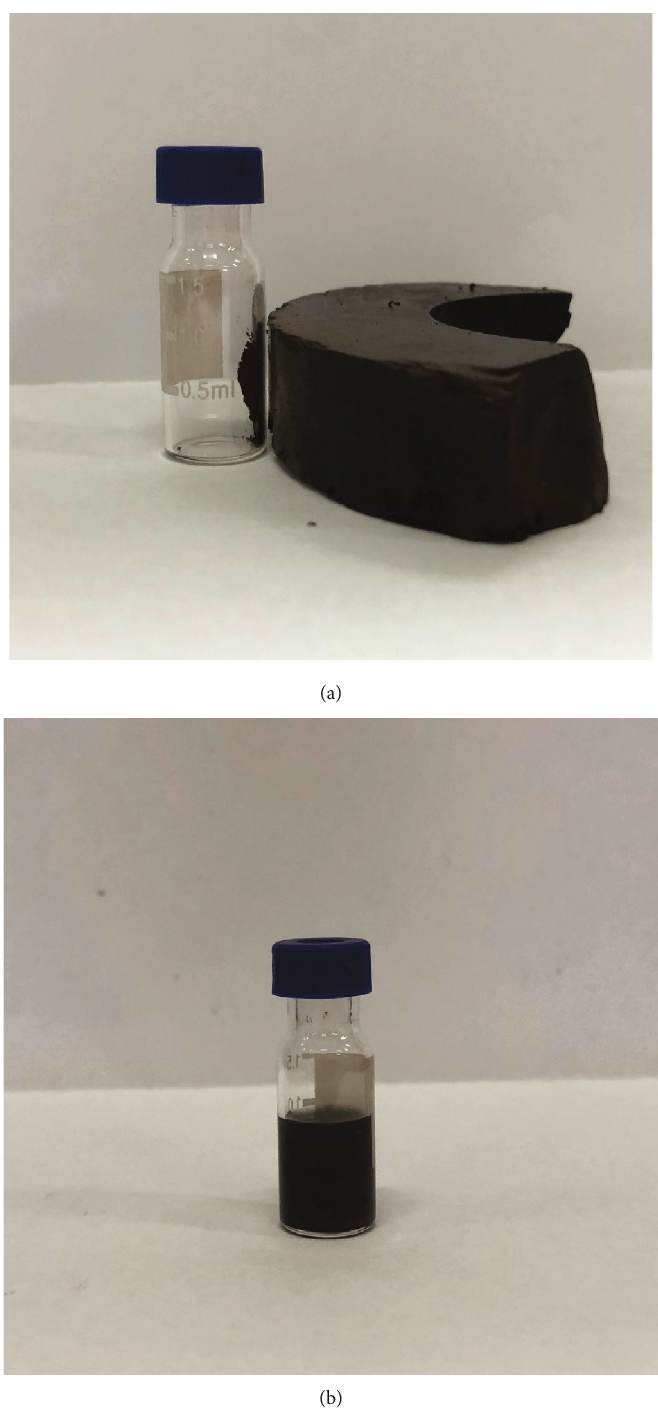
Figure 14: Pictures of magnetic validation of CuFe